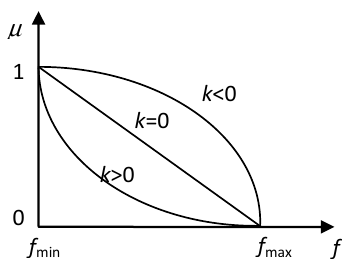
Figure 2. Membership functions with different k